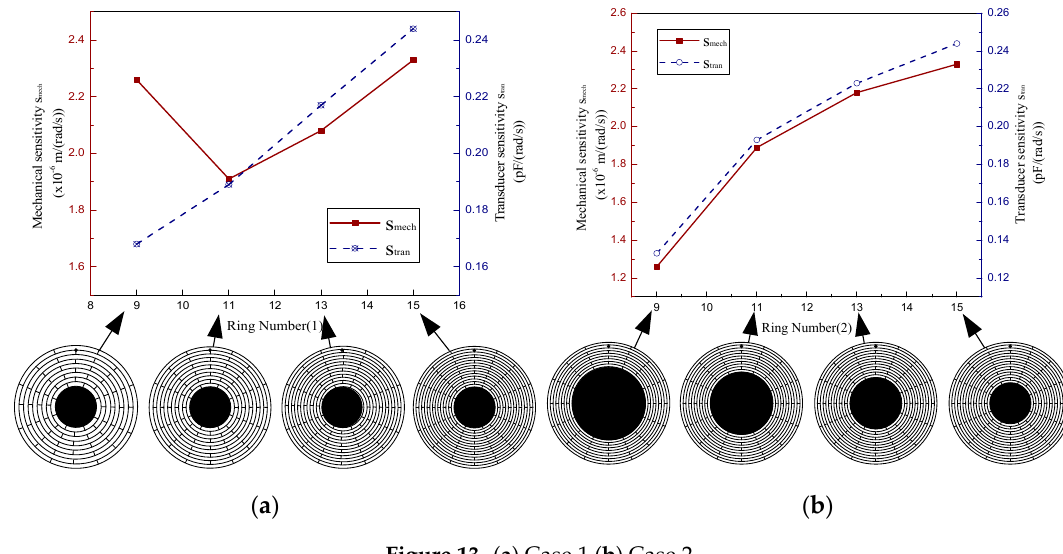
Figure 13. ( a ) Case 1 ( b ) Case 2.